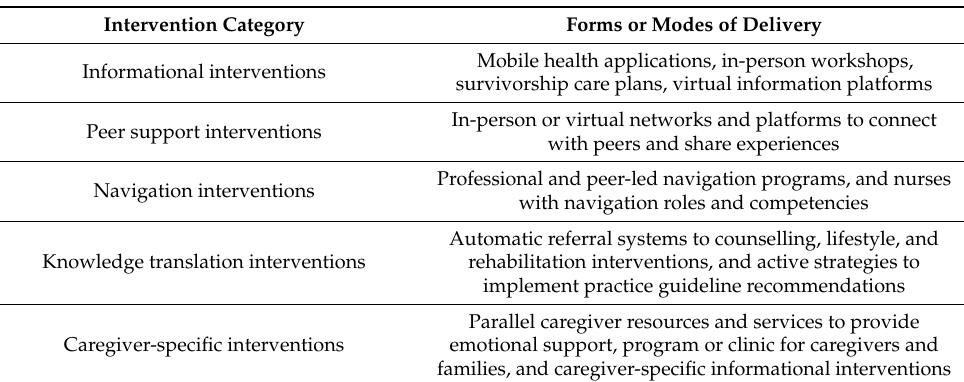
Table 1. Specific examples of interventions by category. Intervention Category Forms or Modes of Delivery Mobile health applications, in-person workshops, Informational interventions survivorship care plans, virtual information platforms In-person or virtual networks and platforms to connect Peer support interventions with peers and share experiences Professional and peer-led navigation programs, and nurses Navigation interventions with navigation roles and competencies Automatic referral systems to counselling, lifestyle, and rehabilitation interventions, and active strategies to Knowledge translation interventions implement practice guideline